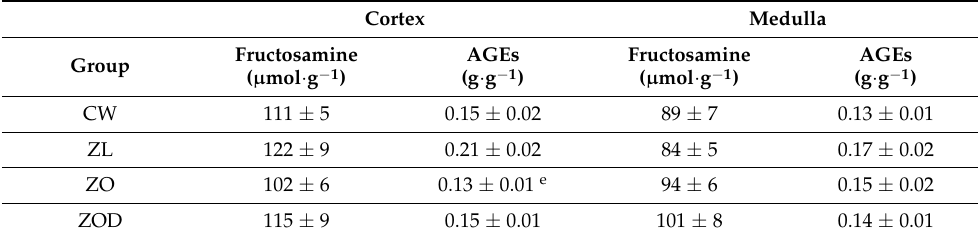
Table 3. Parameters of carbonyl stress in the renal